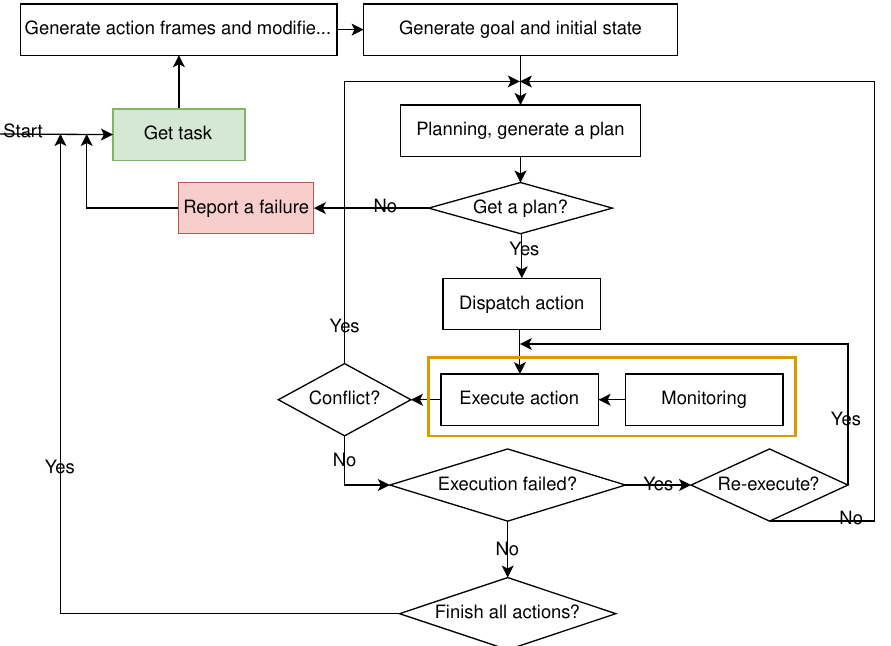
Figure 3. Plan generation, execution, and